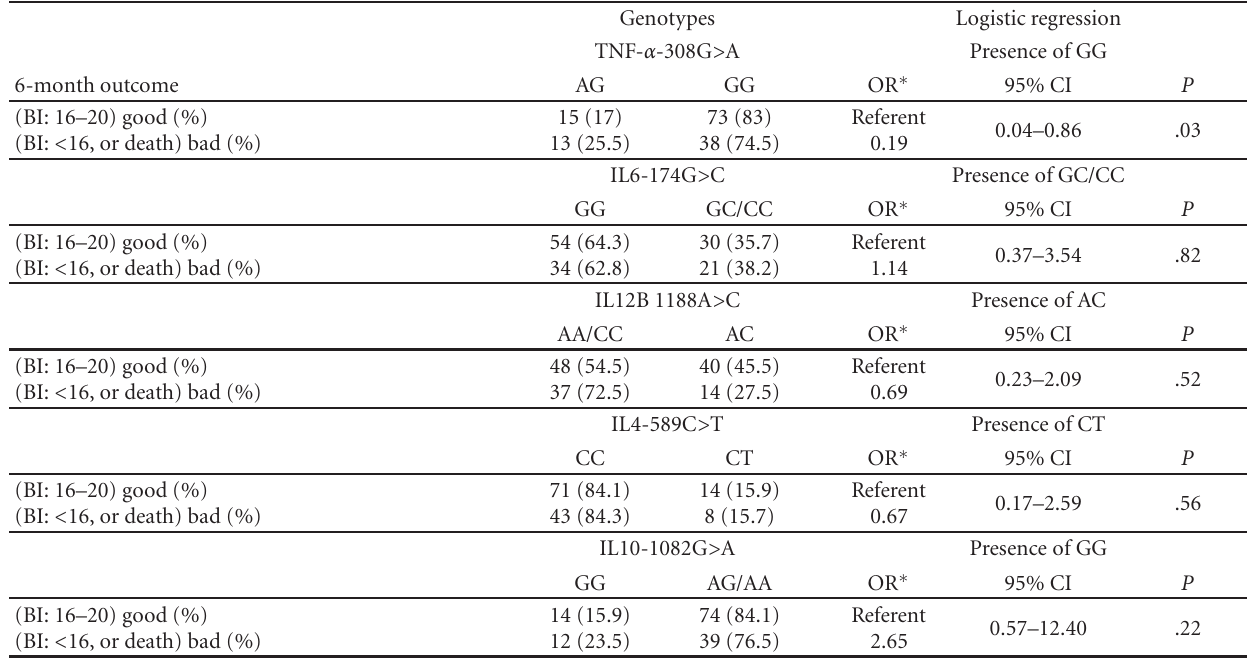
Table 4: Association of inflammatory genotypes with long-term functional outcome of an IS. Genotypes Logistic regression TNF- α -308G > A Presence of GG